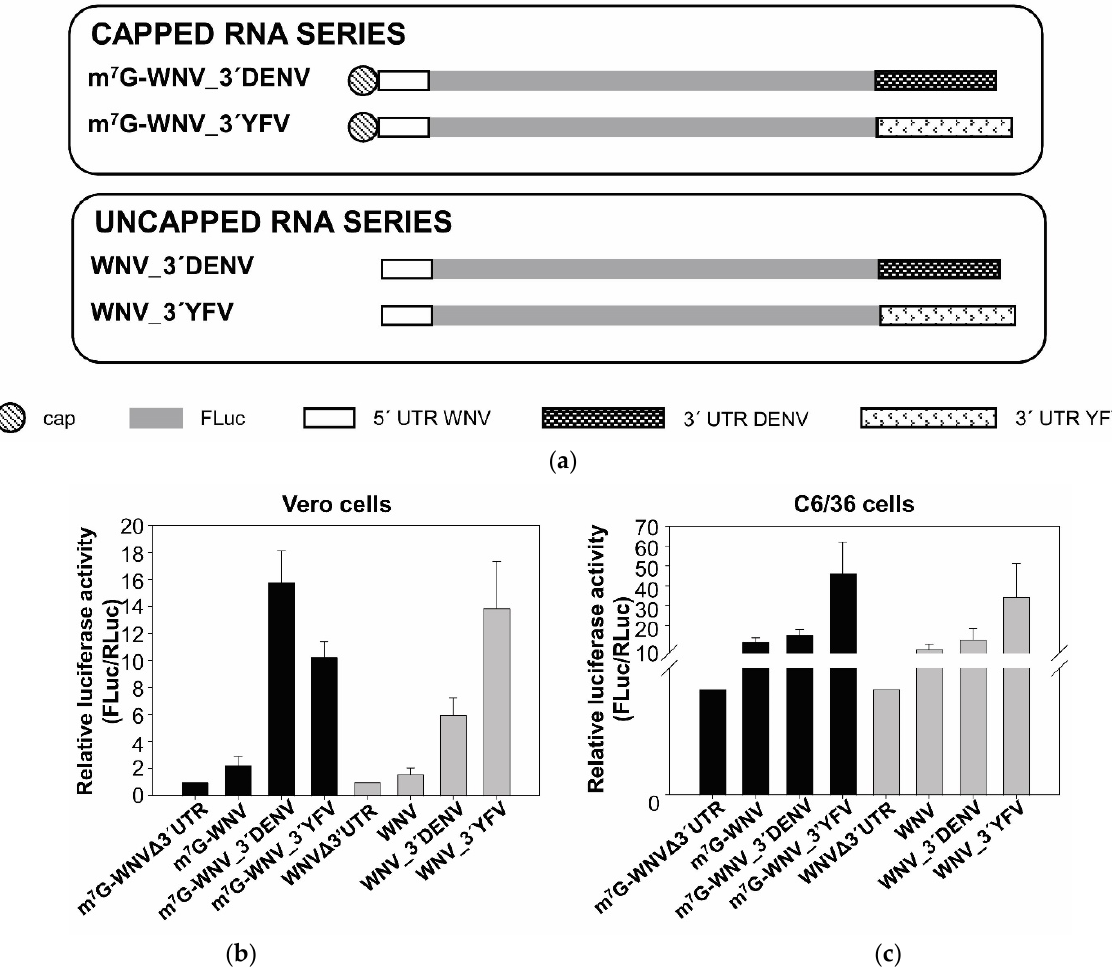
Figure 5. WNV translation initiation is enhanced by the 3 ′ UTRs of DENV and YFV. ( a ) Diagram of the chimeric RNA constructs harbouring the FLuc coding sequence flanked by the 5 ′ end of the WNV genome and the 3 ′ UTR of the DENV or YFV RNA genome. Translation efficiency of different capped and uncapped RNA constructs was determined in Vero and C6/36 cell lines. ( b ) Vero cells were cotransfected with each individual chimeric RNA construct and m 7 G-RLuc RNA. Translation activity was determined as described in Figure 1. Values are referred to that of the corresponding construct lacking any 3 ′ UTR fragment. ( c ) Mosquito C6/36 cells were cotransfected as in ( b ) and translation activity determined as described in Figure 1. Values are the mean of three independent experiments ± standard deviation. Black and grey bars correspond to the values of the capped and uncapped RNA constructs, respectively.